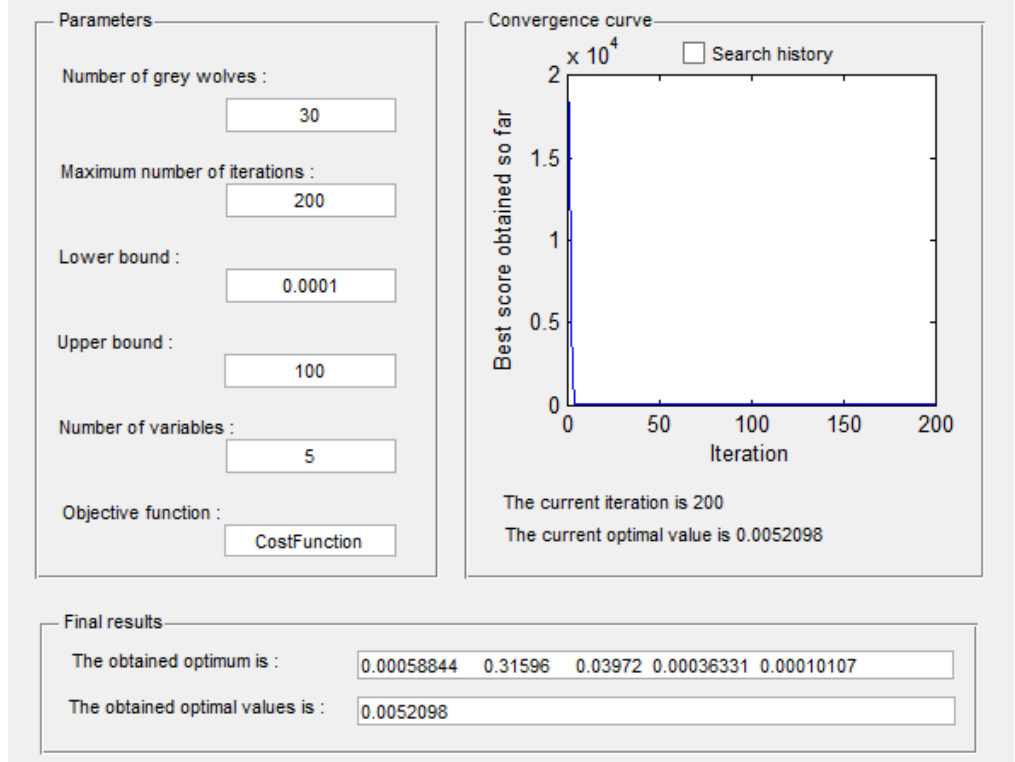
Figure 11. GWO Search history for hydrocarbon combustion